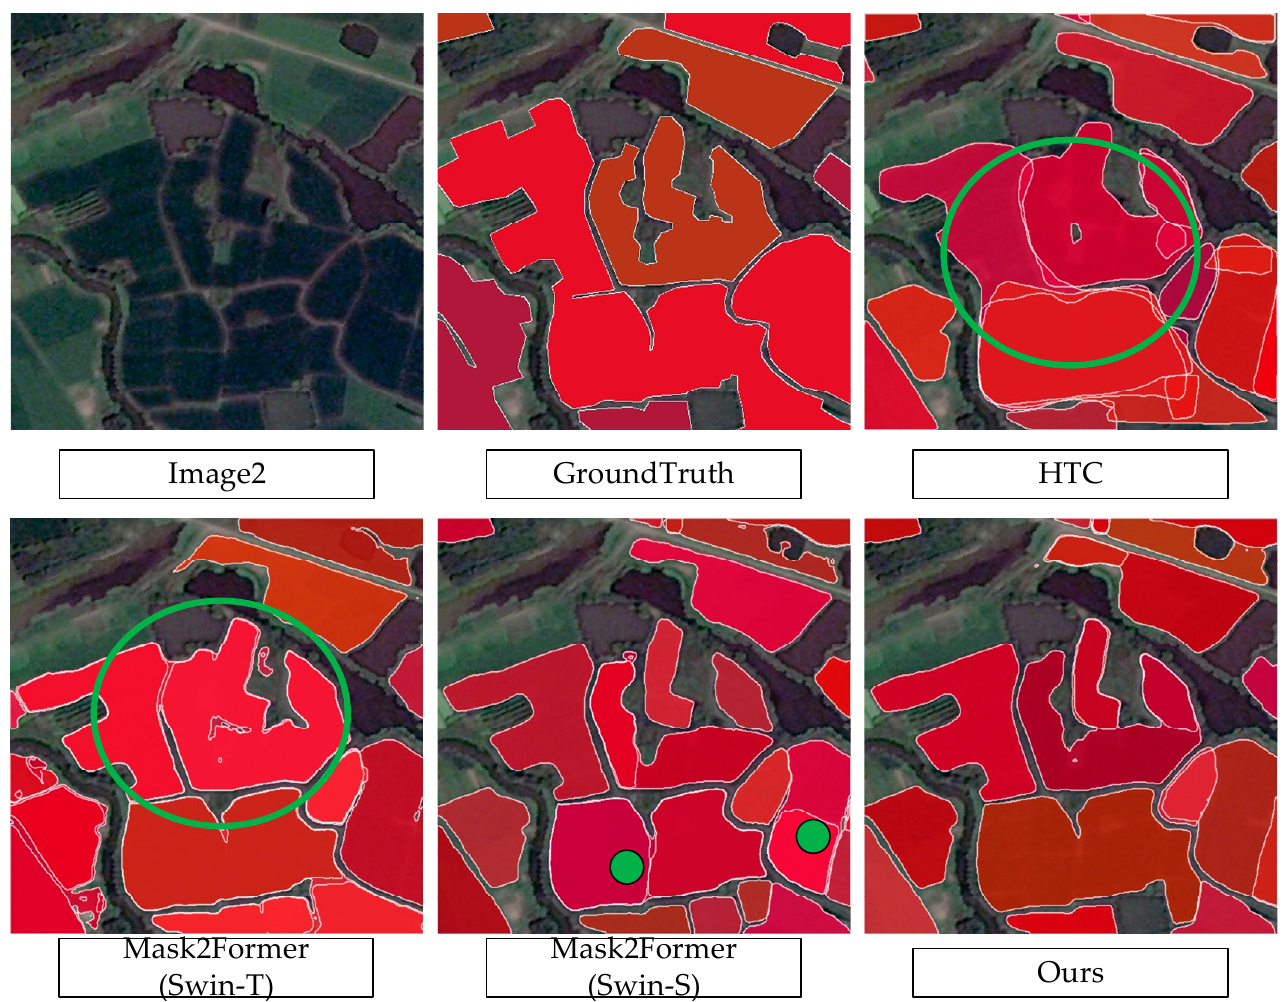
Figure 8. Visual comparison of different models for segmenting irregular fields. Green circles highlight areas of poor extraction.